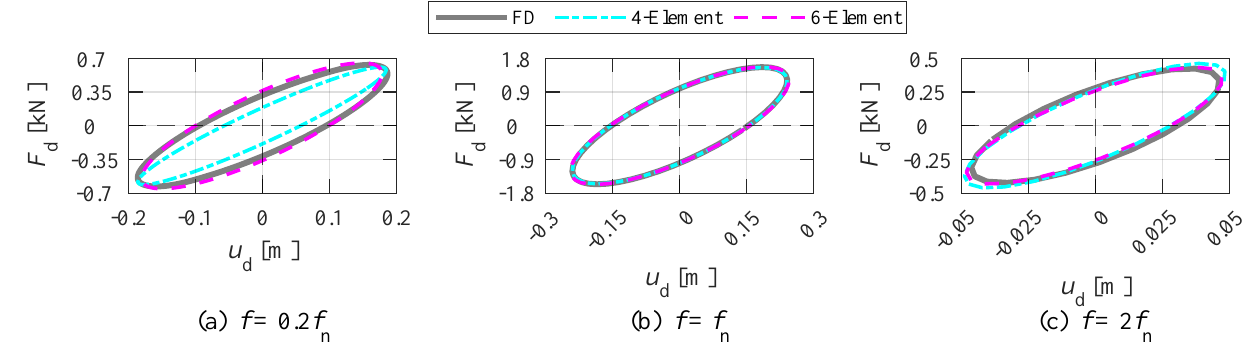
Figure 8. Hysteresis loops of VE dampers subjected to the sinusoidal wave (2H-HH system).